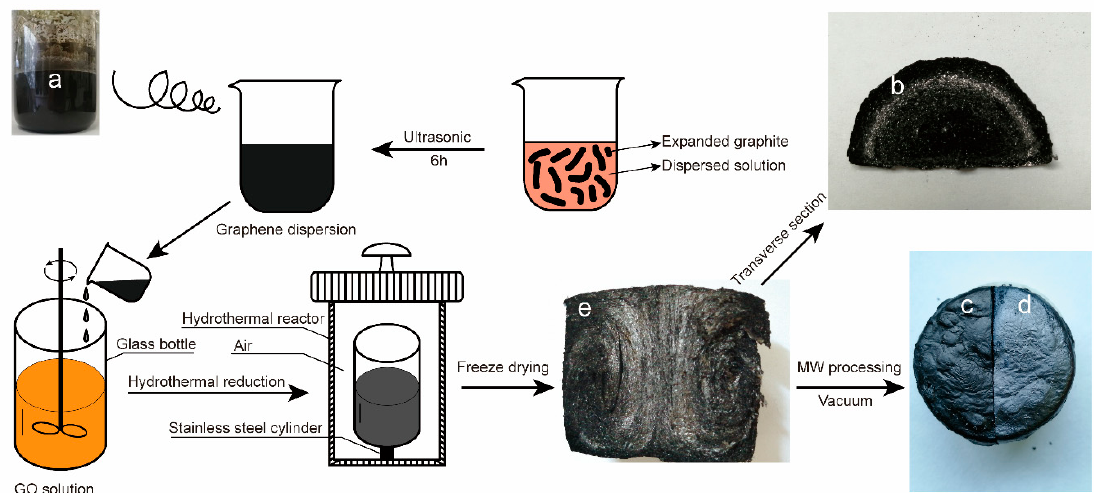
Figure 1. Schematic diagram of anisotropic graphene / graphene oxide (GO) aerogels (AGAs) preparation steps. A digital image of the graphene dispersion ( a ) and a digital image of the AGA’s transverse section ( b ); a digital image of the AGA before ( c ) and after microwave treatment ( d ); a digital image of the AGA’s longitudinal section ( e ).